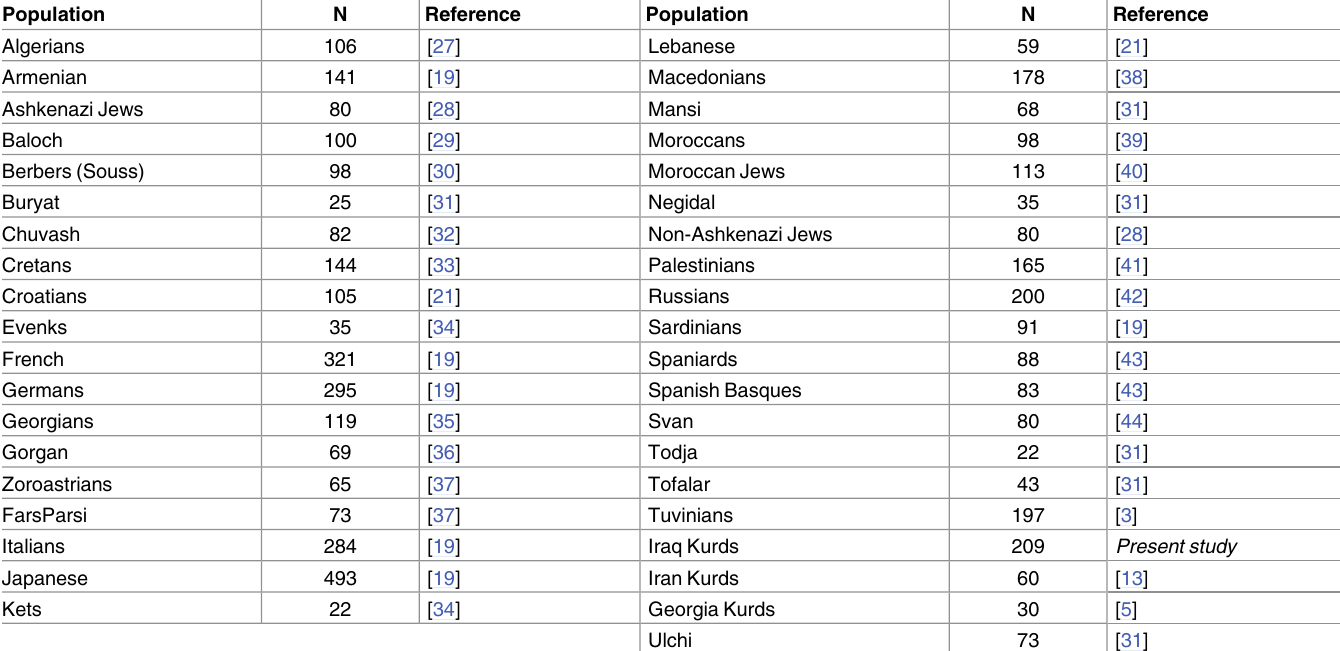
Table 2. Populations used for this